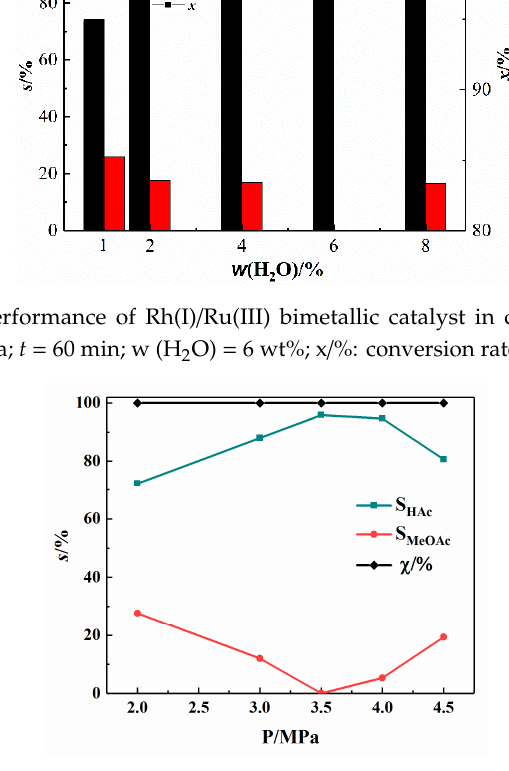
Figure 9. Catalytic performance of Rh(I)/Ru(III) bimetallic catalyst in different solvent contents (T = 190 °C; p = 3.5 MPa; t = 60 min; w (H 2 O) = 6 wt%; x /%: conversion rate of methanol).